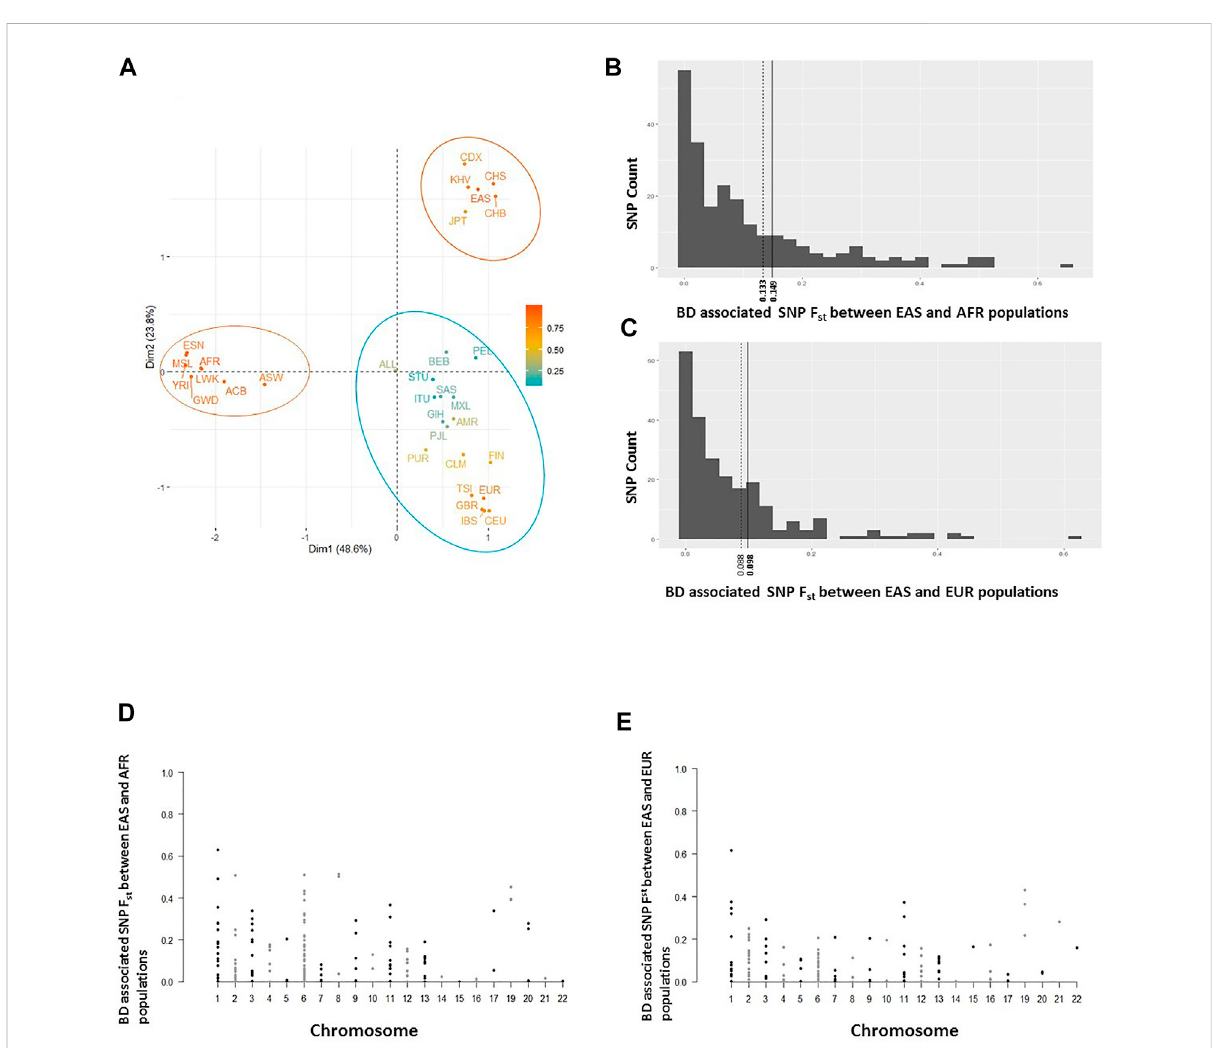
FIGURE 2 (A) Separationofall 261KGenomepopulationsalongthetop2principalcomponents(Dim1 andDim2)basedonprincipalcomponent analyses conducted on a BD associated allele frequency matrix. Ellipses around populations in indicate clusters formed by clustering analysis. (B) Population differentiation (F st ) estimates of BD associated SNPs between East Asian (EAS) and African (AFR) populations. Solid and dashed vertical lines shows genome-wide SNP F st and mean F st of BD associated SNPs, respectively. (C) F st estimates of BD associated SNPs between East Asian (EAS) and European (EUR) populations. Solid and dashed vertical lines shows genome-wide SNP F st and mean F st of BD associated SNPs, respectively. (D) DistributionofBDassociatedSNPs ’ EAS-AFRF st valuesalonghumanchromosomes. (E) DistributionofBDassociatedSNPs ’ EAS-EURF st valuesalong human